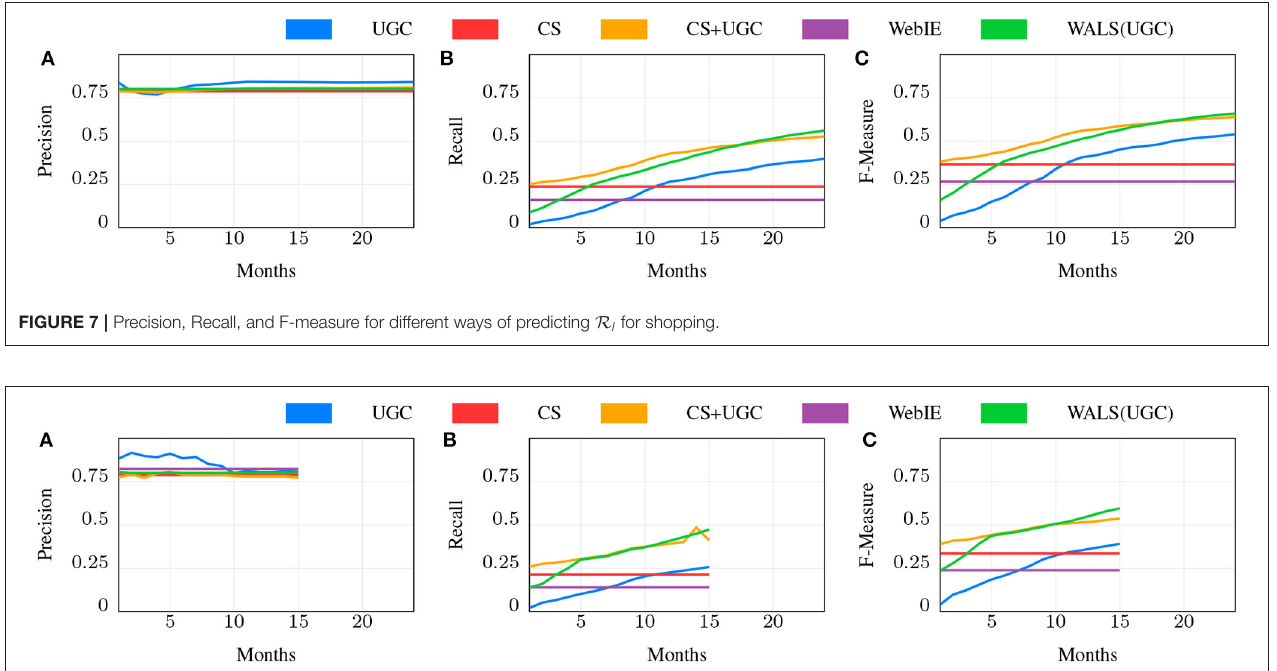
FIGURE 8 | Precision, Recall, and F-measure for different ways of predicting R I for